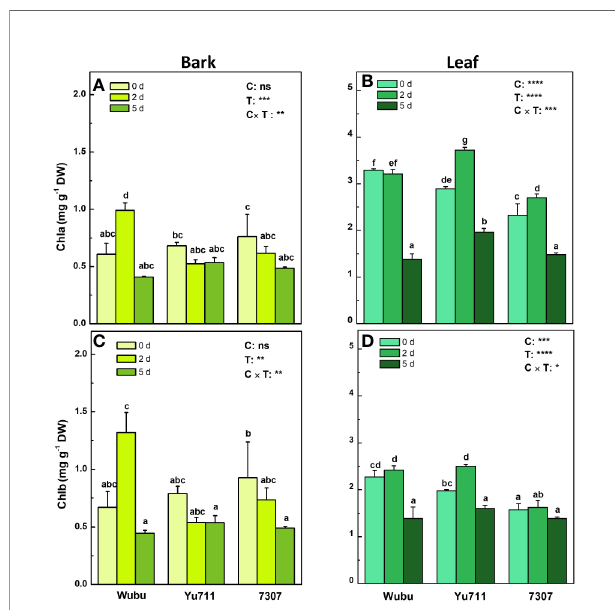
FIGURE 3 | Concentrations of chlorophylls a (A, B) and b (C, D) in bark and leaves of mulberry cultivar Wubu, Yu711, and 7307 exposed to progressive drought stress for 0, 2, and 5 days (denoted as 0 d, 2 d, and 5 d), respectively. The bar indicates mean ± SE (n = 6). Different letters on the bars indicate signi fi cant difference. ANOVAS of cultivars (C), time (T), and their interaction (C × T) are also indicated. * P < 0.05; ** P < 0.01; *** P < 0.001; **** P < 0.0001; ns, not signi fi